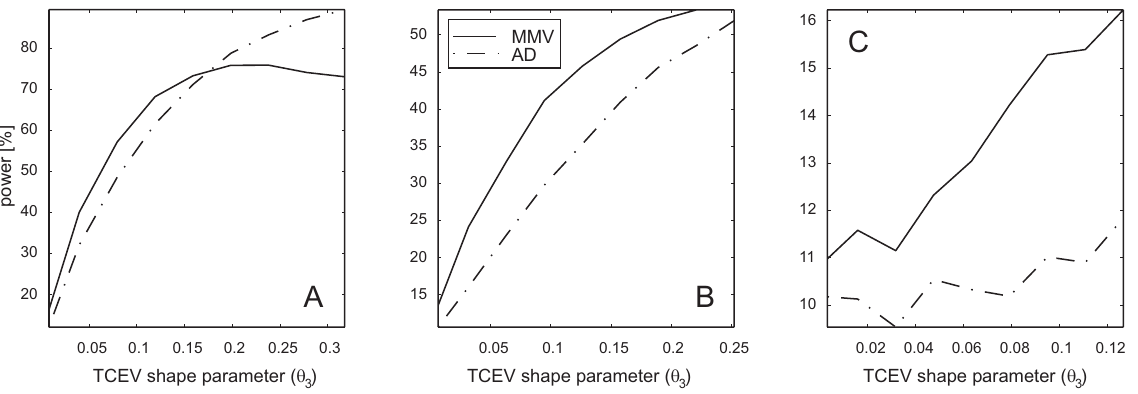
Fig. 3. Power of the modified maximum-value (MMV) and Anderson-Darling (AD) tests for a TCEV parent distribution. In panel (A) θ 4 = 10, in panel (B) θ 4 = 5, and in panel (C) θ 4 = 2. The sample size is n =